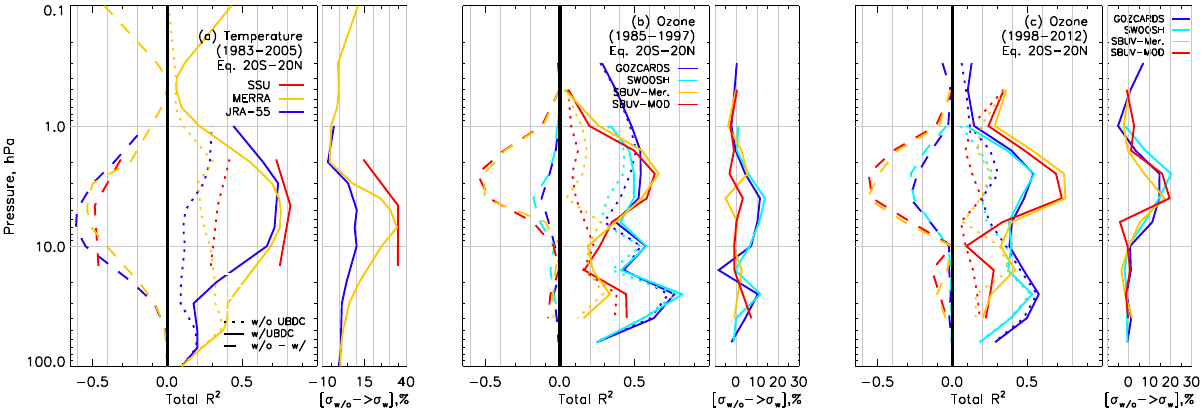
Figure 10. Coefficient of determination summed over all regressors ( R 2 c ) and the reduction in the Student’s t test-based error on regressor coefficients (%) for equatorial profiles (positive values) for (a) temperature from 1983 to 2005, for ozone between (b) 1985 and 1997, and for ozone between (c) 1998 and 2012 for various datasets (see legends). For R 2 , dotted lines represent estimates without the UBDC index, solid lines with, and the difference (without UBDC minus with UBDC) is given as negative and dashed